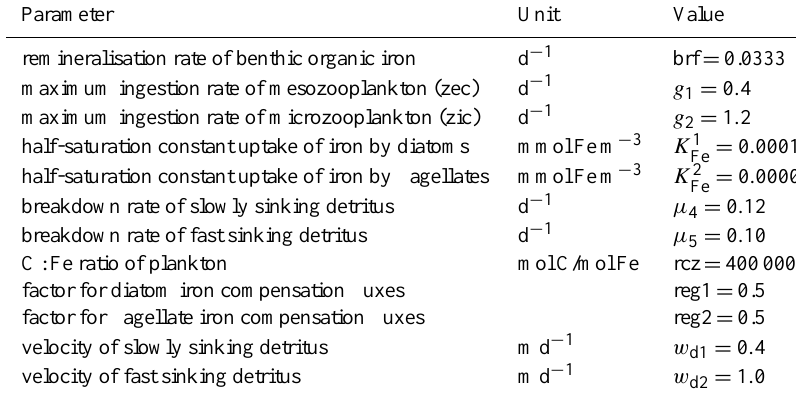
Table A5. Parameters and their values. All rate values are valid for 10 ◦ C. Parameter Unit